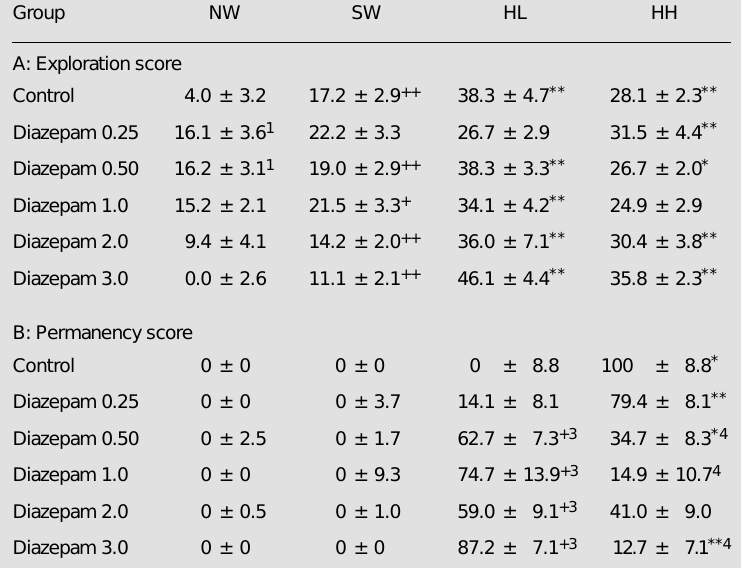
Table 1 - Percent activity in one arm with respect to the total activity displayed in the APM by rats treated with different doses of diazepam.